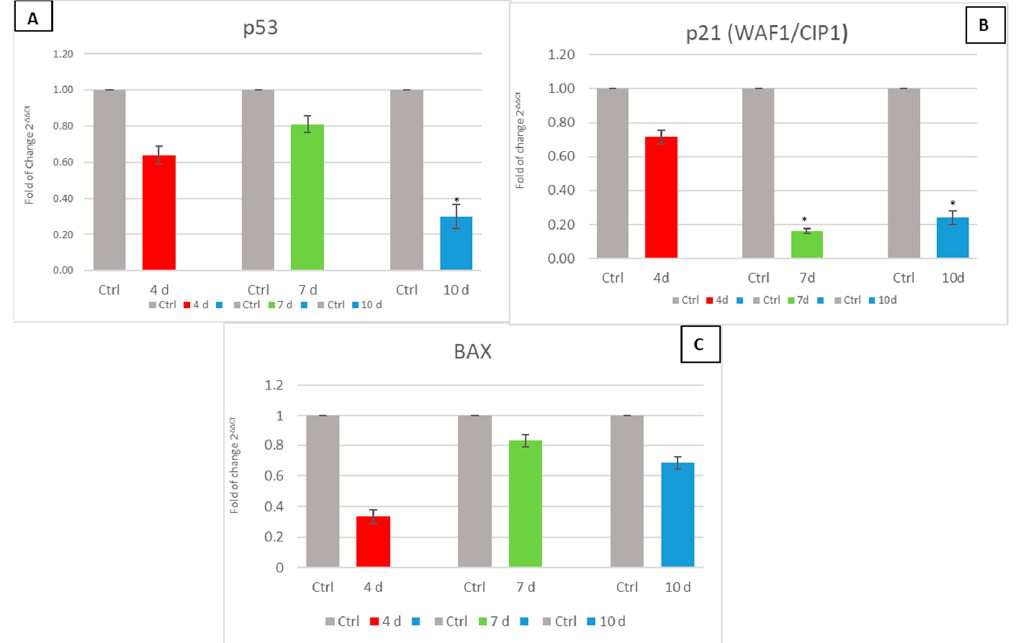
Figure 6. The expression of p53 (Panel ( A )), p21 (WAF1/CIP1) (Panel ( B )), and BAX (Panel ( C )) was evaluated in human Adipose-derived stem cells (hADSCs) cultured with 4d-MCF-7-EM (4d – red bars), 7d-MCF-7-EM (7d – green bars), or 10d-MCF-7-EM (10d – blue bars). The mRNA levels for each gene were normalized to Glyceraldehyde-3-Phosphate-Dehydrogenase (GAPDH) and expressed as fold of change (2 −ΔΔ Ct ) of the mRNA levels observed in untreated control hADSCs (Ctrl - Grey bar) defined as 1 (mean ± SD; n = 6). Data are expressed as mean ± SD referred to the control (* p ≤ 0.05).